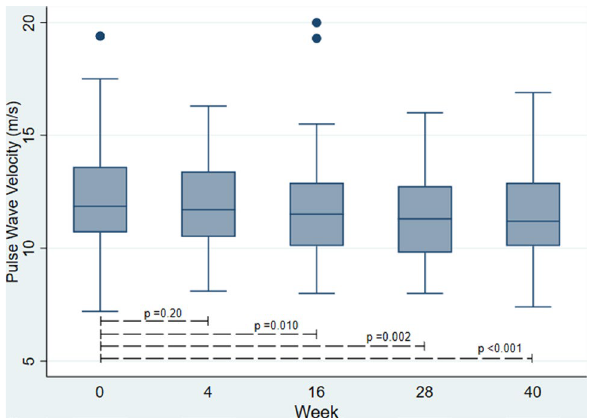
Figure 1. Box plot of aortic PWV at baseline (visit 1), week 4 (visit 2), week 16 (visit 3), week 28 (visit 4), and week 40 (visit 5) including p values from pairwise comparisons. (The figure is graphed using Stata version 16.0 (StataCorp LLC, College Station, TX, USA, https ://www.stata